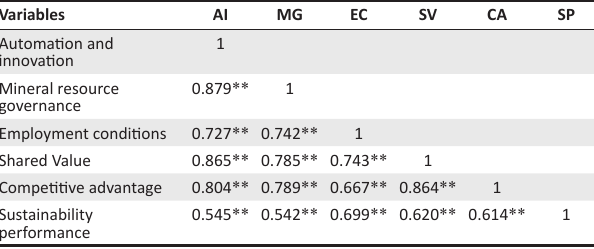
TABLE 4: Correlation’s analysis matrix.